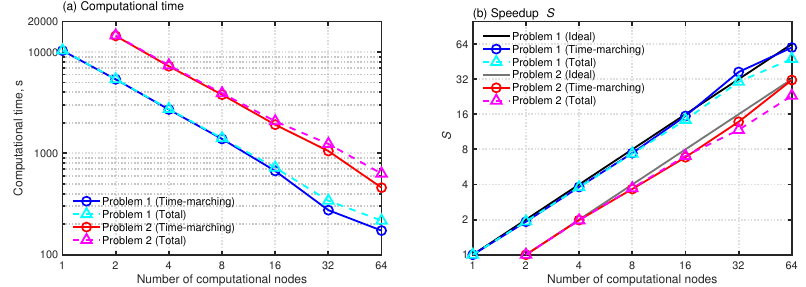
Figure 5. Results of scalability tests of ( a ) computational time and ( b ) speedup S